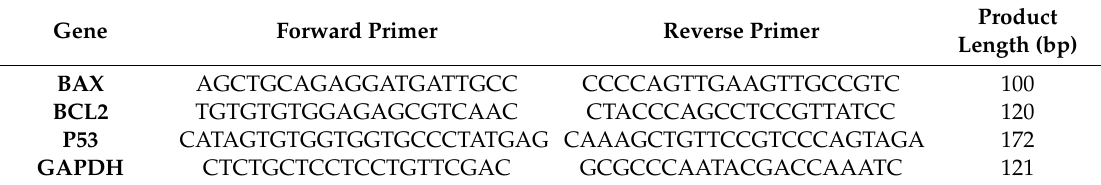
Table 7. Primer sequences for real